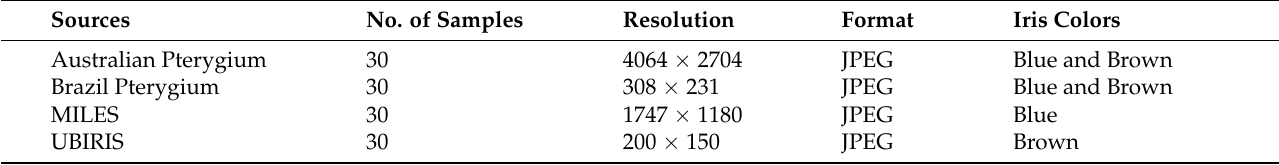
Table 2. Summary of the Zaki et al. [19] pterygium